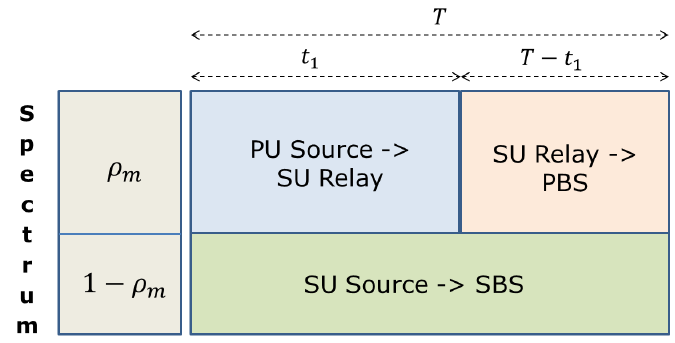
Figure 2. Bandwidth allocation and time slot division for primary user (PU) and secondary user